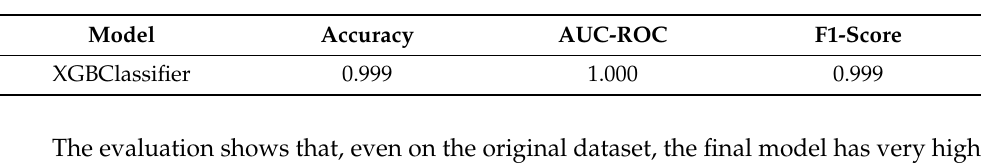
Table 4. Evaluation of Original Dataset on Final